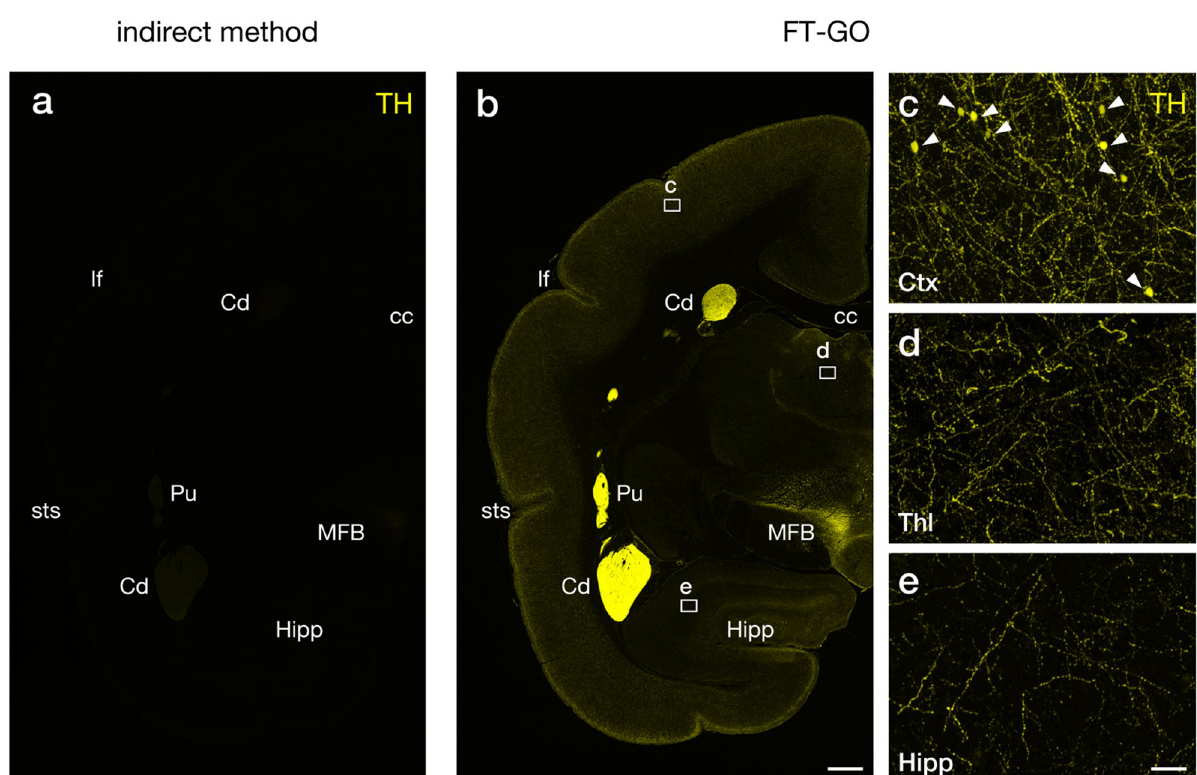
Figure 4. CA fiber innervation in the marmoset brain visualized with FT-GO. (a,b) TH IF in marmoset brain sections visualized with an indirect ( a ) and FT-GO method ( b ) (n = 2 animals for each condition). Images are acquired with the same parameters for comparisons. c–e, Higher magnification images in rectangles in ( b ). Arrowheads in ( c ) indicate TH-positive cell bodies in the neocortex. CF647 tyramide is used for color development in the FT-GO method. cc corpus callosum, Cd caudte nucleus, Ctx cerebral cortex, Hipp hippocampus, lf lateral fissure, MFB medial forebrain bundle, Pu putamen, sts superior temporal sulcus, Thl thalamus. Scale bars: 1 mm in ( b ) and 50 µm in ( e